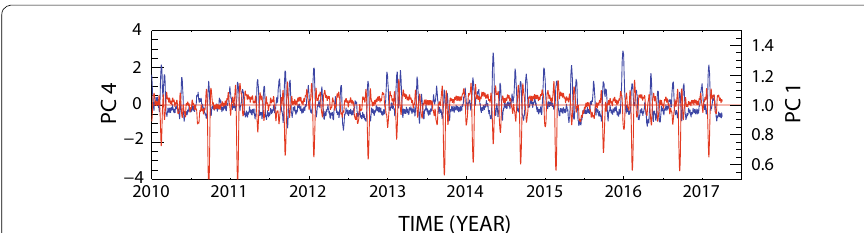
Fig. 10 Correlation between the PC time series of CSEOF mode 1 and the detrended time series of CSEOF mode 4. The two PC time series exhibits a significant negative correlation (